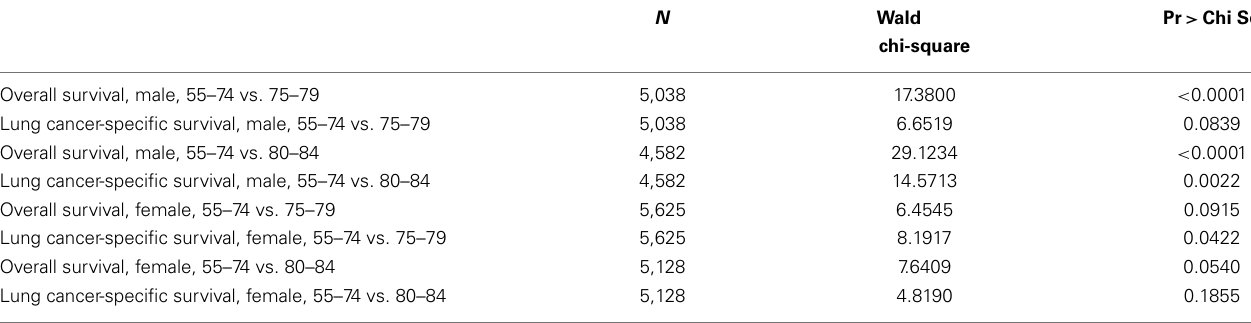
Table 4 |Wald tests of the interaction effect between age group and treatment in Cox proportional hazards model .